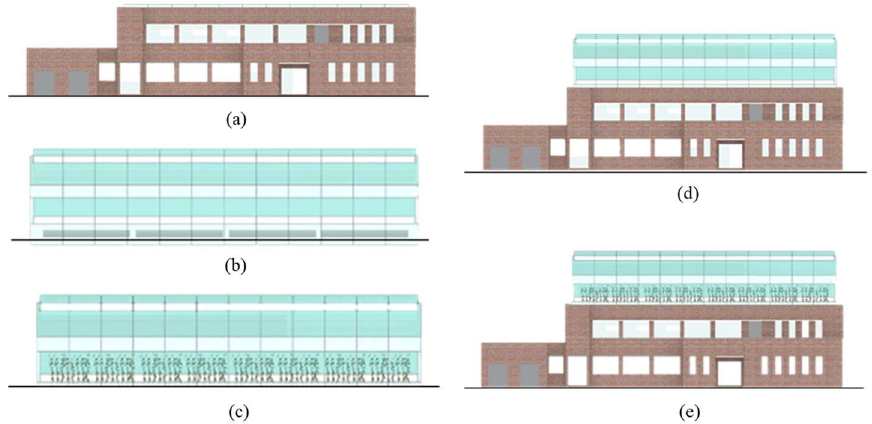
Figure 9. Scenario analysis in this study: ( a ) office building, ( b ) single-span greenhouse without crop, ( c ) single-span greenhouse with crop, ( d ) BiRTG without crop, and ( e ) BiRTG with crop.